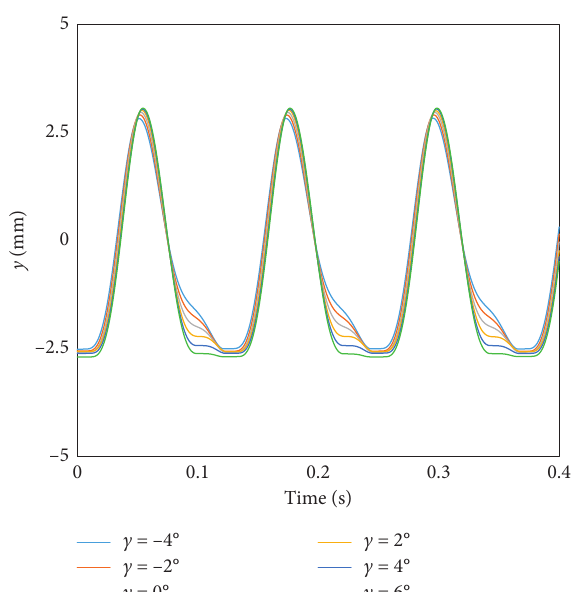
Figure 17: The influence of side frame angle on the response of the suspension system when excitation amplitude � 15 mm and frequency � 7Hz.